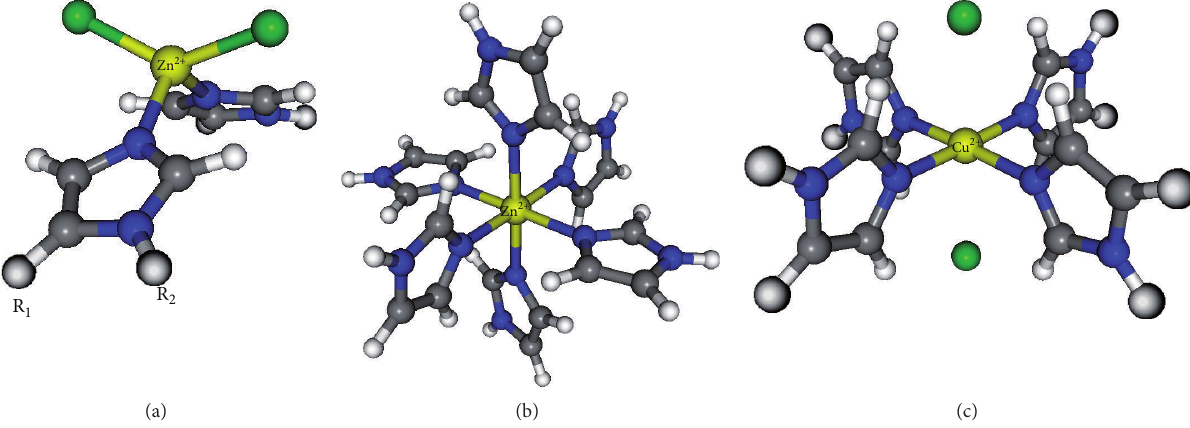
Figure 9: Coordination geometries [38]. (a) Tetrahedral [Zn(Me-Im) 2 Cl 2 ], (b) octahedral [ZnIm 6 ] 2+ , and (c) tetragonal [CuIm 4 Cl 2 ] and [Cu(Me-Im) 4 Cl 2 ]. R 1 and R 2 are defined as in Scheme 1. The coordination geometry for Cu 2+ complexes is tetragonal D4 h symmetry for the methylated imidazoles, equivalent to unsubstituted imidazole. The imidazole ligands are almost perpendicular to the coordination axis and the chlorides are weakly bound axially [38, 154–156]. However, regarding Zn 2+ complexes, unsubstituted imidazole forms octahedral complexes [38, 155] [Zn(Im) 6 ] 2+ , whereas the methylated imidazoles form tetrahedral C2v complexes [38, 156, 157] [Zn(Me-Im) 2 Cl 2 ] despite the large excess of imidazole ligand.